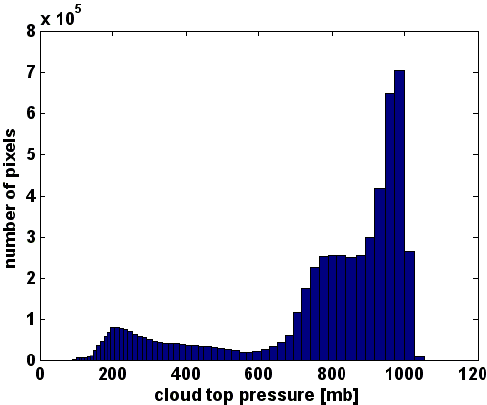
Fig. 4. Distribution of cloud top heights over the study area con- structed from 5-km